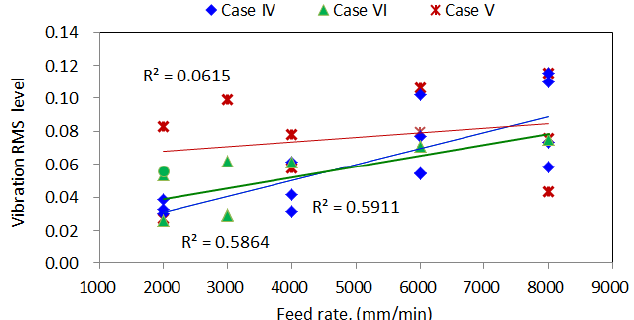
Figure 16. Scatters of vibration level against feed rate for stages with different